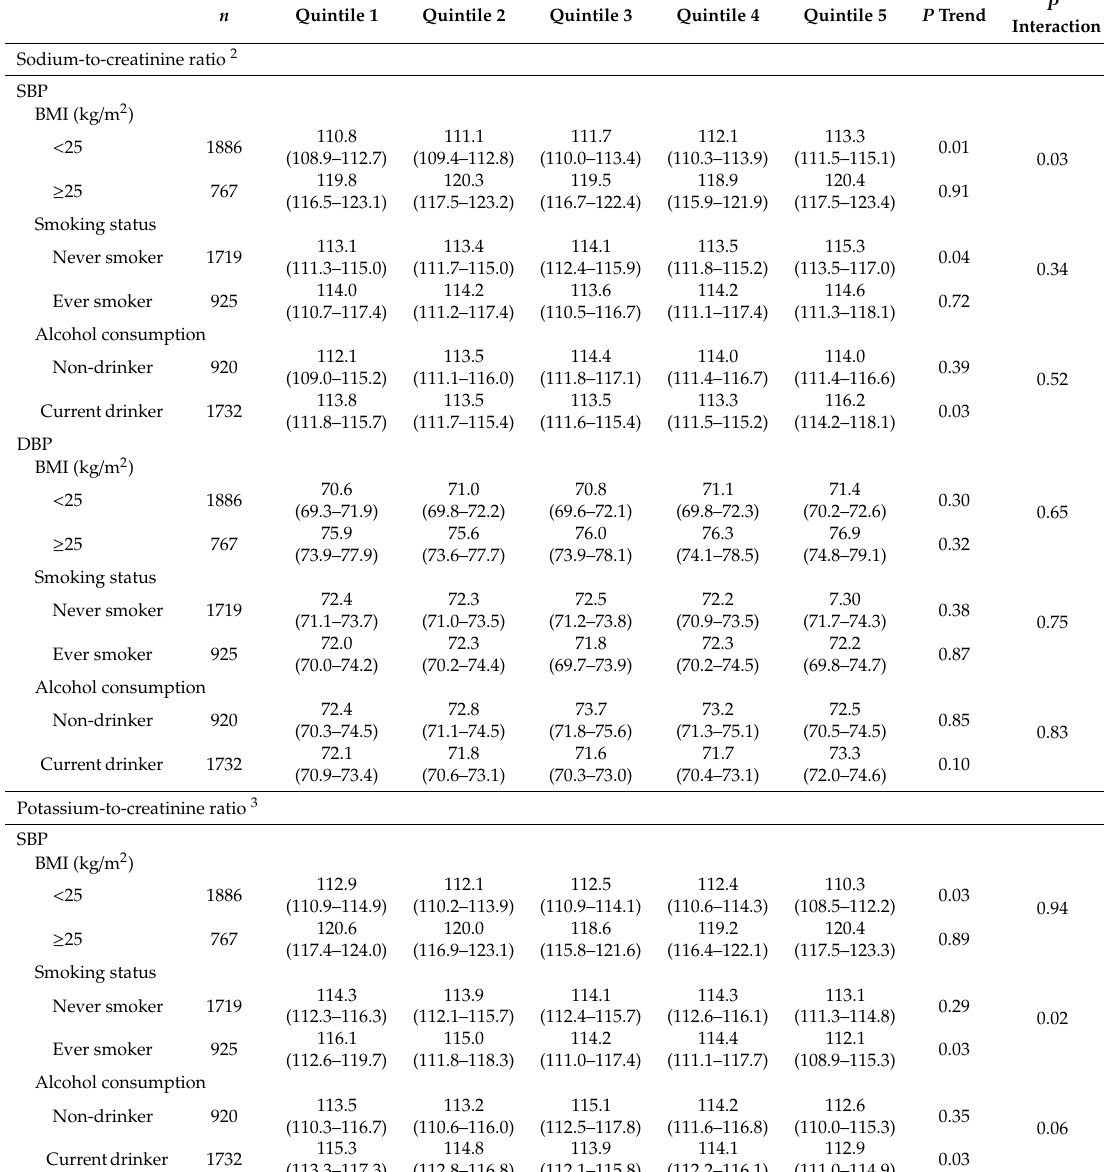
Table 3. Multivariate-adjusted geometric means (95% CIs) 1 of systolic and diastolic blood pressures (mmHg) according to urinary sodium-to-creatinine and potassium-to-creatinine ratios by BMI,